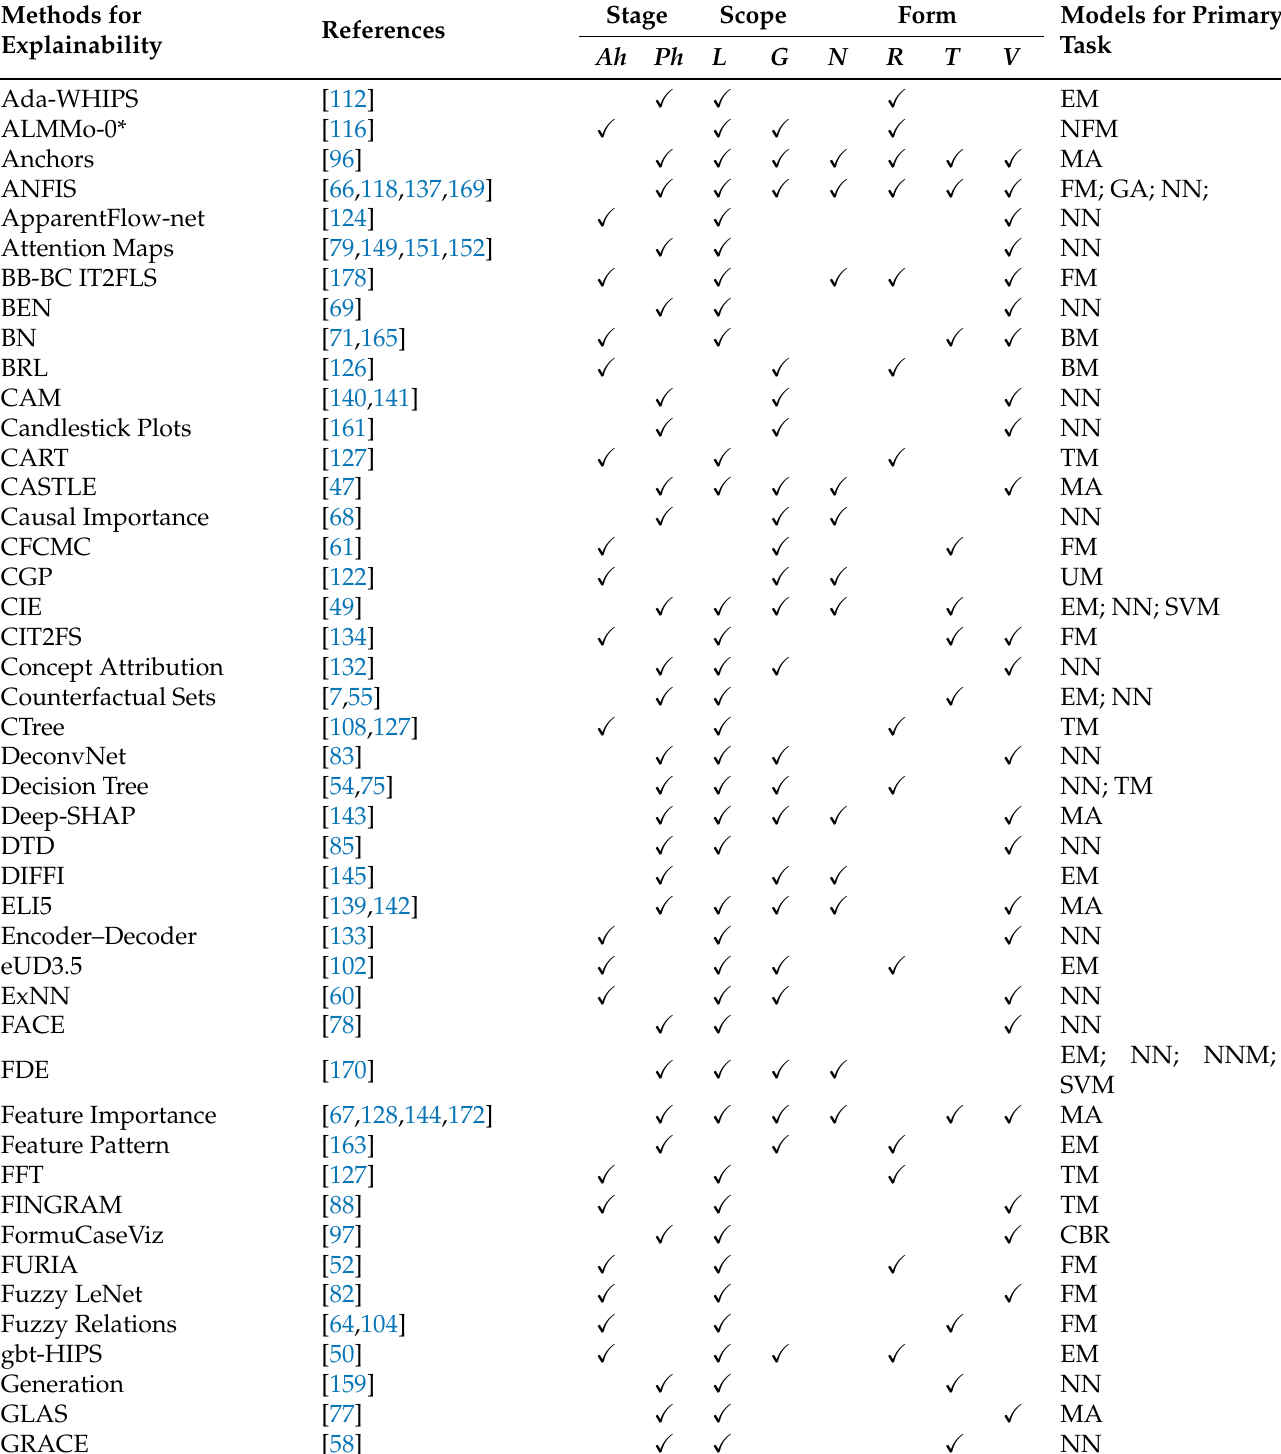
Table 6. Methods for explainability, stage ( Ah : ante hoc; Ph : post hoc) and scope ( L : local; G : global)